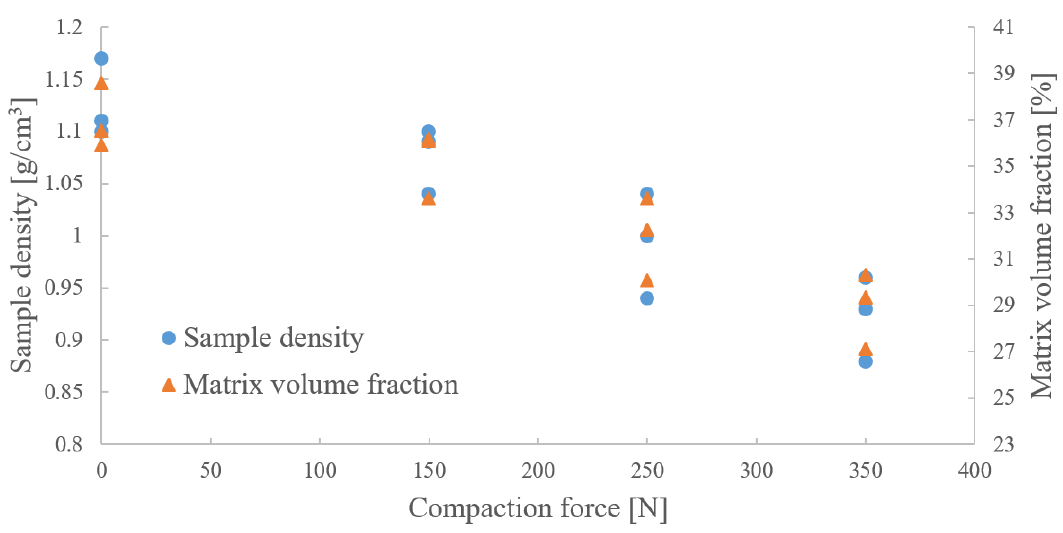
Figure 5. Physical properties of manufactured samples.